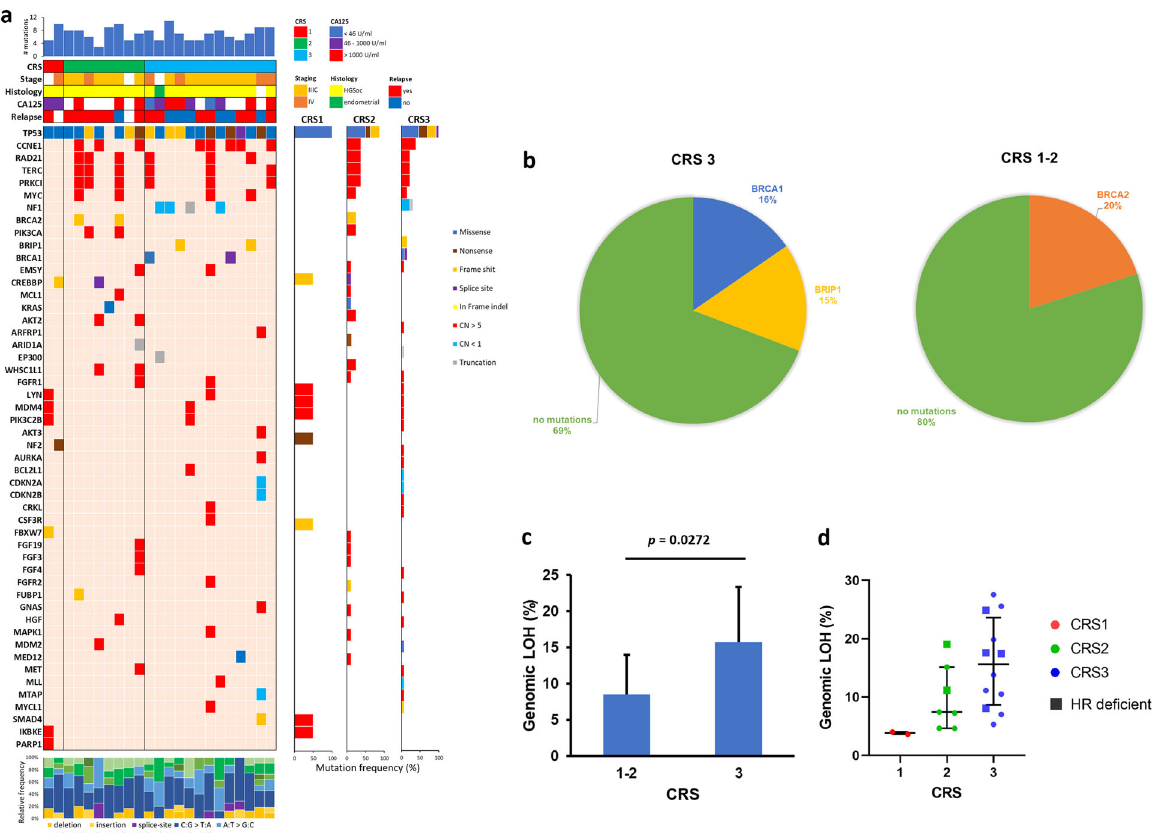
Fig. 1 Genomic alterations in EOC biopsy samples. a Mutation plot showing individual EOC biopsy samples on the x axis from left to right ordered by type of response: CRS1, CRS2, and CRS3. Gene alterations are annotated according to the color panel on the right side of the image. The frequency of appearance of the mutation in the CRS group is plotted on the right panel. Mutation burdens and type of base-pair substitution and indels are displayed in the top and bottom panels, respectively. Clinical data are displayed in the top panel. b Frequency of CRS3 and CRS1/2 biopsy samples with HR pathway-related genomic alterations. c Average genomic LOH in CRS3 and CRS1/2 biopsy samples. d Genomic LOH in CRS1, CRS2, and CRS3 biopsy samples. Samples with alterations in HR pathway-related genes are indicated (HR de fi